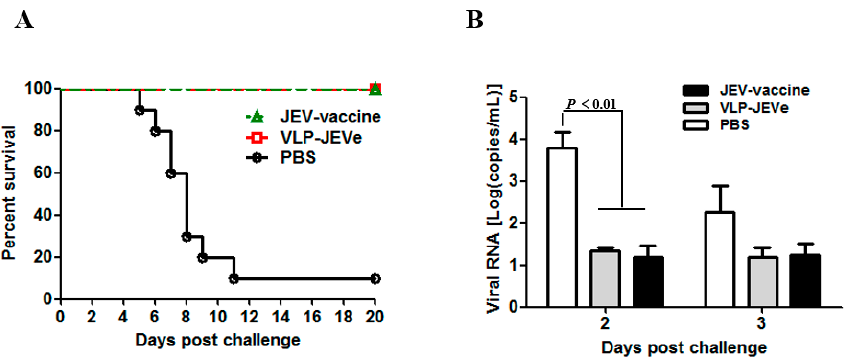
Figure 4. Immunization and challenge in mice. ( A ), The mice were vaccinated with purified VLP- JEVe, live-attenuated SA 14 -14-2 vaccine and PBS and challenged via i.p route with a lethal dose of 5 × 10 6 PFU of JEV. The mice were monitored daily for 20 days. Kaplan–Meier test was used for sur- vival analysis. ( B ), After challenge of two weeks of immunization of mice, the spleens were isolated and quantitative real-time PCR was performed to measure the virus content. The lower detection limit of the assay is indicated by the dashed line. Data are shown as mean ± SEM, and statistical differences between vaccinated groups and PBS groups were indicated by p < 0.01.